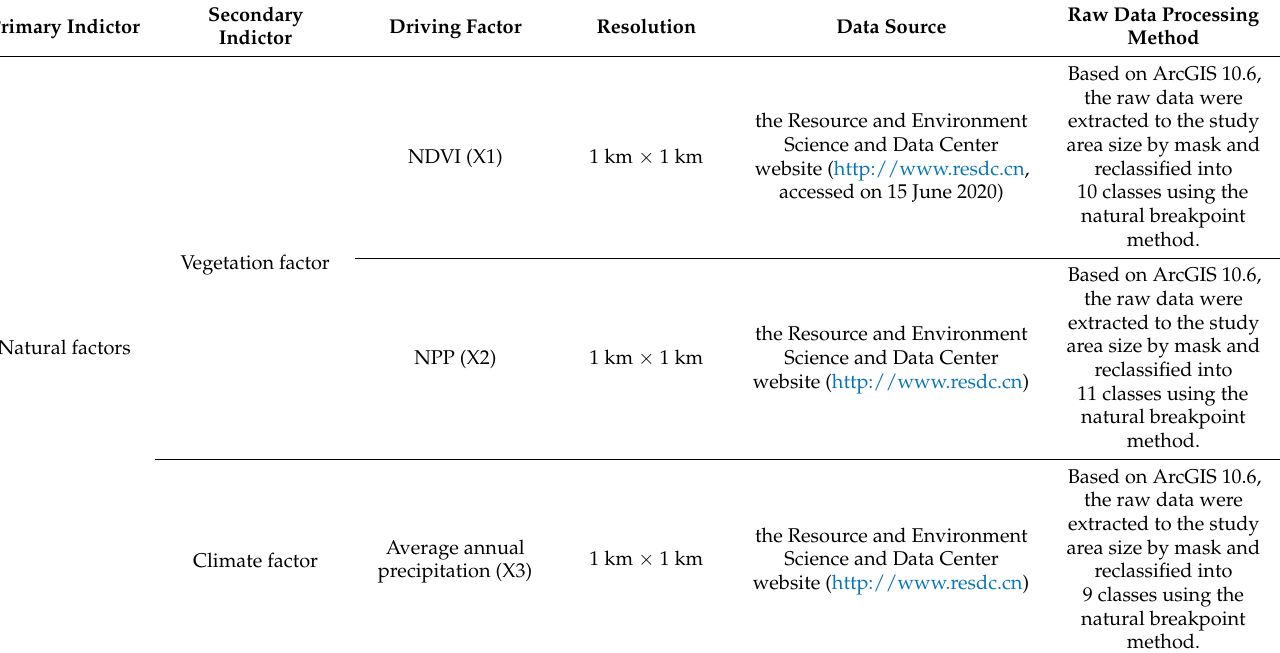
Table 2. The indictor system of geographic detector